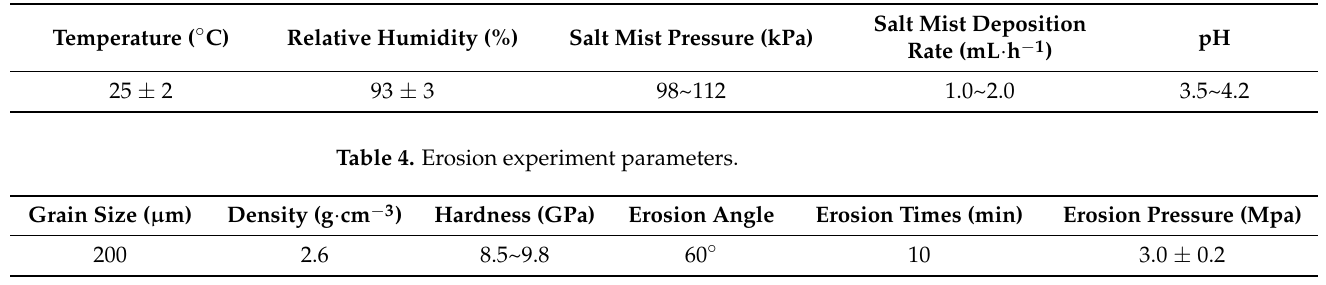
Table 4. Erosion experiment parameters.